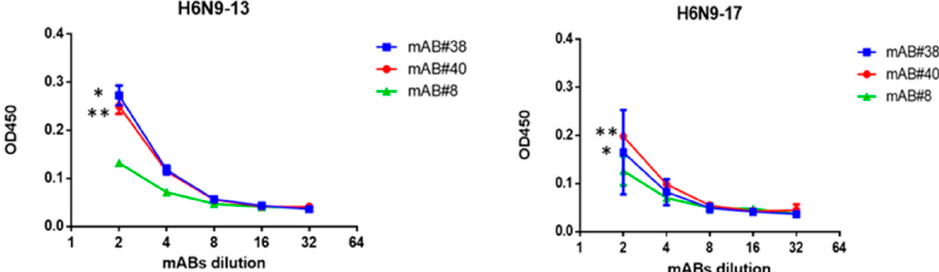
Figure 7. The binding curves of N9-specific mAB to A/H6N9-13 and A/H6N9-17 influenza viruses (20 HAU). Starting mAB concentration: mAB#8-0.47 mg/mL; mAB#38-0.5 mg/mL; mAB#40-0.5 mg/mL.* p < 0.05, Mann–Whitney U-test.** p < 0.05, Mann–Whitney U-test.